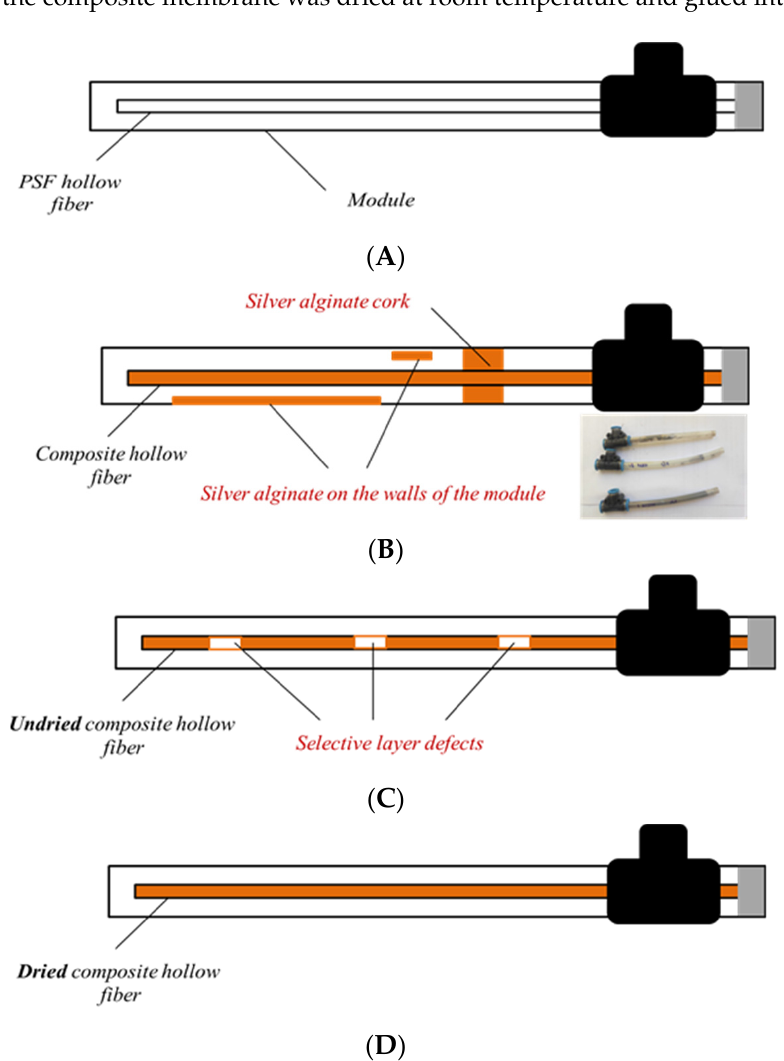
Figure 7. Schematic representation of the appearance of composite hollow fiber membranes and the problems encountered during their creation by different methods: ( A )—initial module with hollow fiber porous support, ( B )—composite hollow fiber silver alginate membrane with silver alginate cork and silver alginate into the module walls, ( C )—defect composite hollow fiber silver alginate membrane, ( D )—defect free composite hollow fiber silver alginate membrane.